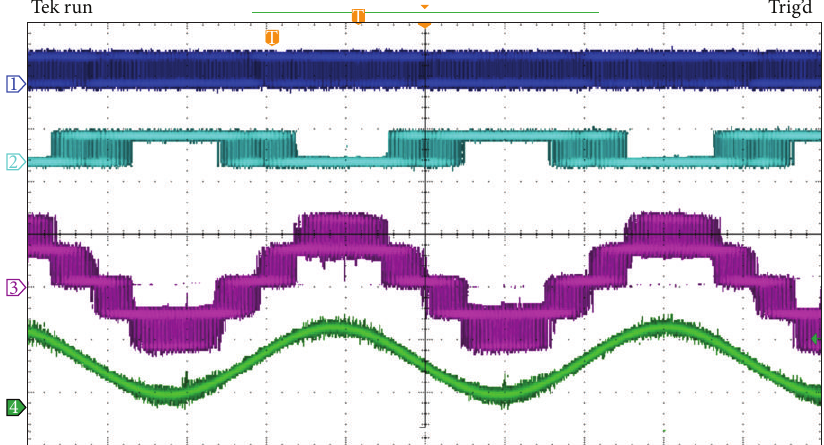
Figure 14: Operation of the system under a steady state. Top to bottom: control signals 𝑆 1 and 𝑆 3 , respectively, (5V/div each), output current (2A/div), sinusoidal reference (2V/div). Time 4ms/div.